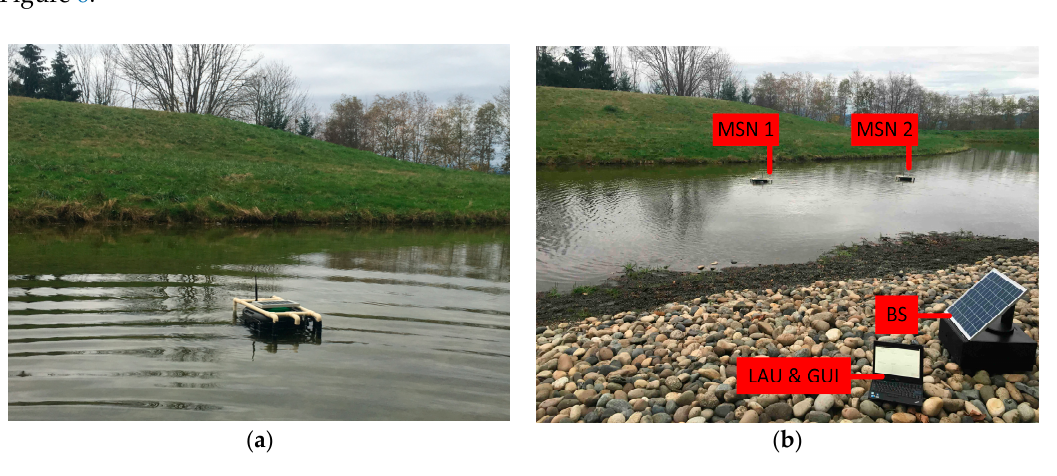
Figure 6. Field deployment of the developed platform at the Yosef Wosk Reflecting Pool: ( a ) Deployment of the MSN in the pool; ( b ) Deployment of the platform in the